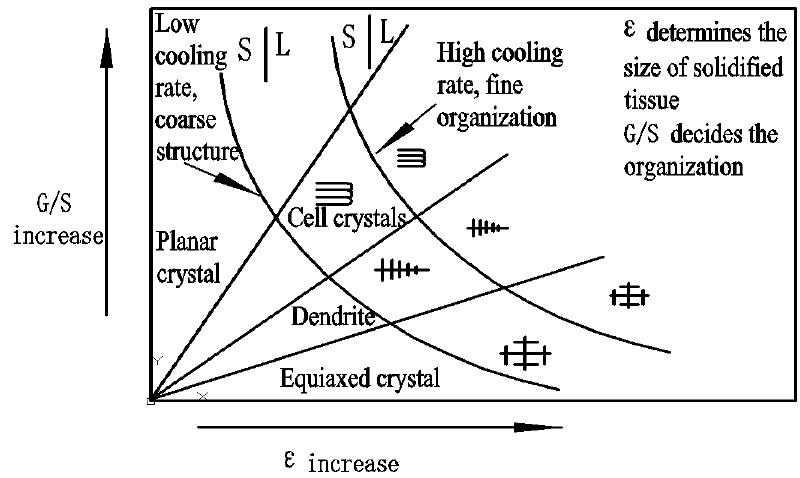
Figure 8. Solidification structure and the relationship between its size and characteristic parameters.